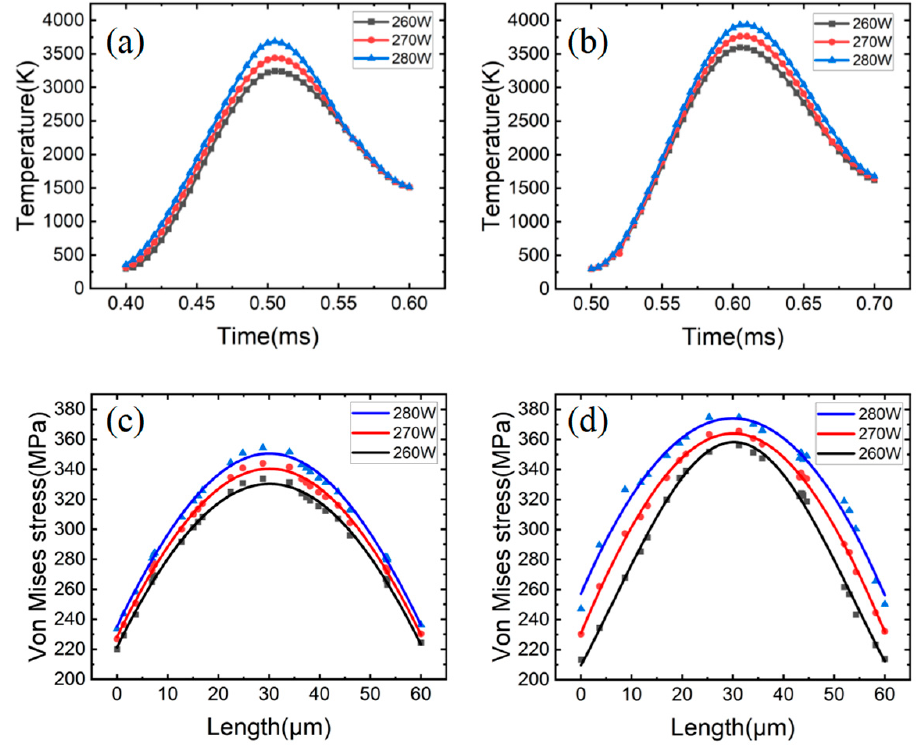
Figure 10. Temperature variation under different process parameters ( a ) 1200 mm/s; ( b ) 1000 mm/s. Change in stress value under different process parameters ( c ) 1200 mm/s; ( d ) 1000 mm/s.